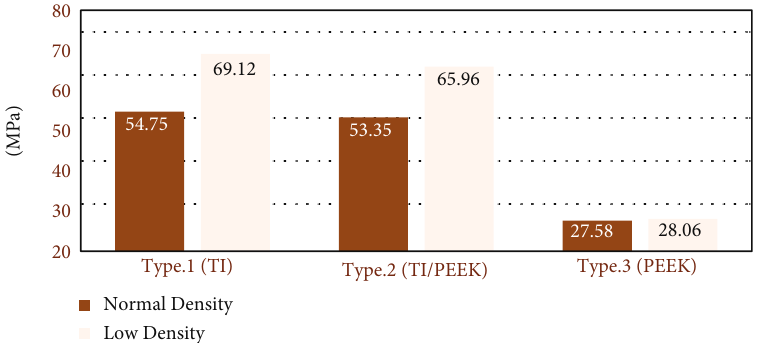
Figure 4: Maximum von Mises stresses (MPa) on implants.